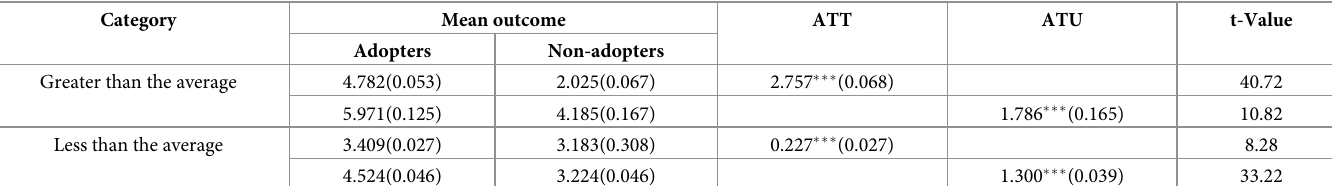
Table 9. Impact of new technology adoption on family farms’ income under different operating scales: Estimated by ESR model. Category